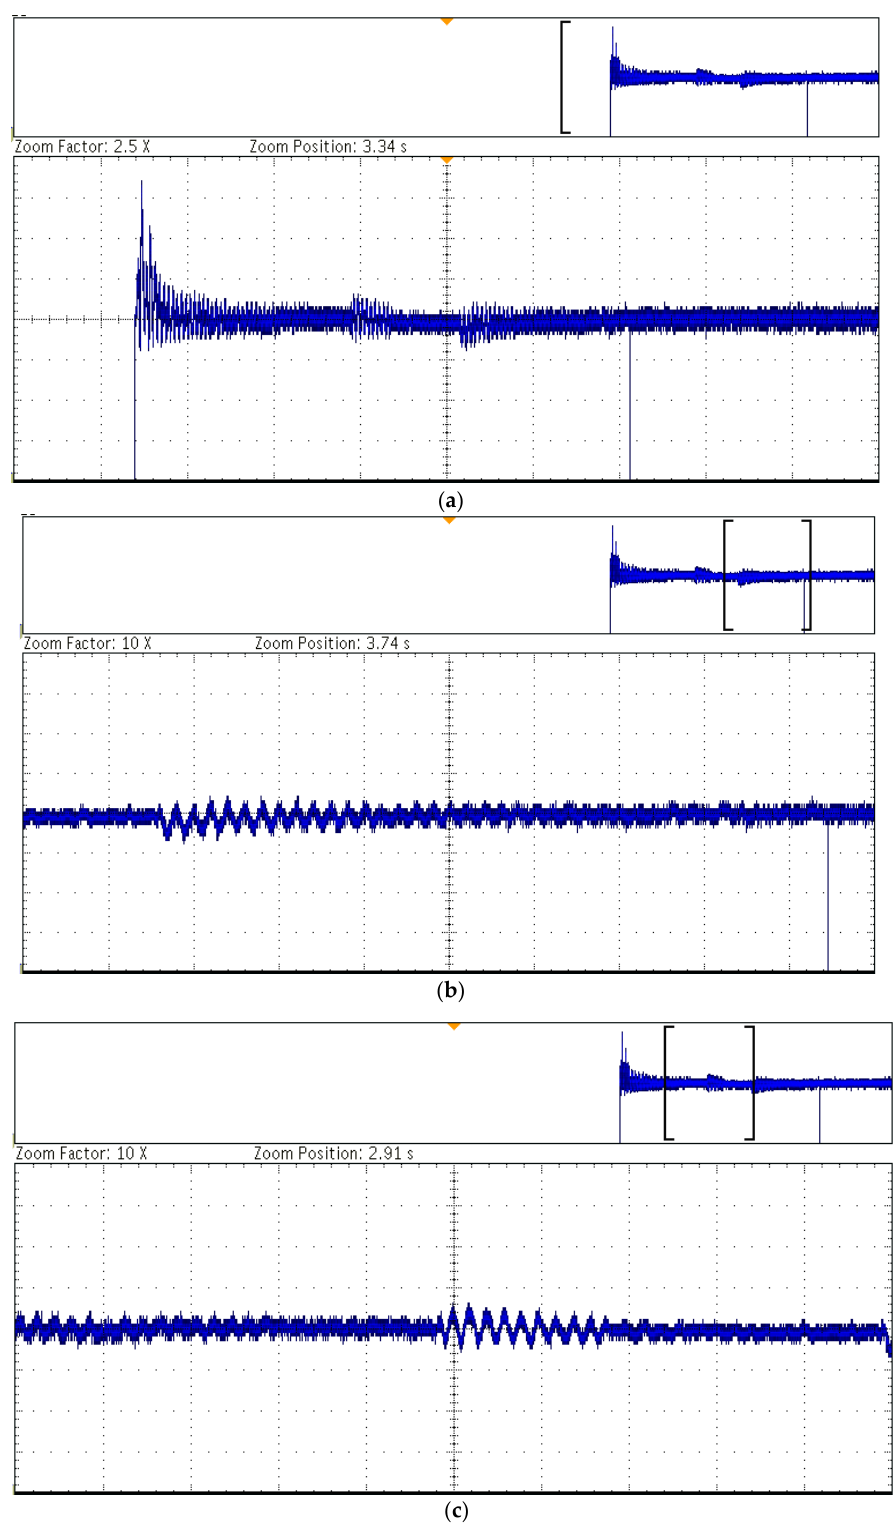
Figure 15. ( a ) Overall DC bus voltage waveform. ( b ) DC bus voltage waveform at the moment of voltage lift. ( c ) DC bus voltage waveform at the moment of voltage recovery. Though the whole process of real time simulation can be obtained, this research ’s control strategy can limit the DC bus voltage in the moment of voltage lift below 1.1 pu, and the high wear process oscillation amplitude is small, conducive to DFIG stable oper- ation. 7. Conclusions In this paper, the causes of the DC bus voltage rise were analyzed, and the overvolt- age limiting mechanism was analyzed. On this basis, the control strategy was investi- gated. The simulation analysis verified the correctness of the theoretical analysis and the effectiveness of the control strategy, and the following conclusions were drawn. (1) In the DFIG HVRT process, the grid side and stator output reactive current limit is influenced by the initial value of active power and the degree of voltage lift, so a current limiting section is required when designing the reactive current reference. Additionally, the rate of change in the grid side current will have a large impact on the DC bus voltage. (2) This paper proposes a method for reducing the rate of change in active and reactive currents to limit overvoltage at the DC bus point and investigates a HVRT control strategy that takes into account the dynamic changes in grid side currents. (3) Analysis of busbar overvoltage lift limiting conditions, on the basis of which active and reactive current reference values are set, can effectively reduce DC busbar over- voltage. At the same time, the DFIG can be controlled to absorb inductive reactive power from the grid according to different degrees of voltage rise. (4) The key parameter k in the grid side current reference value has a certain influence on the DC bus voltage. By introducing the gray wolf search algorithm, a convenient and accurate global optimum search for the key parameters can be carried out. This paper provides a reference for the study of fault ride through technology for doubly fed induction wind turbines, and also provides some reference values for the anal- ysis of grid side fault currents. Author Contributions: Conceptualization, J.D. (Jun Deng) and J.D. (Jiandong Duan); Data curation, T.G. and Y.Z.; Formal analysis, Z.Q.; Funding acquisition, J.D. (Jun Deng) and N.X.; Investigation, N.X.; Methodology, Z.Q.; Software, Z.Q., T.G. and Y.Z.; Supervision, J.D. (Jiandong Duan);